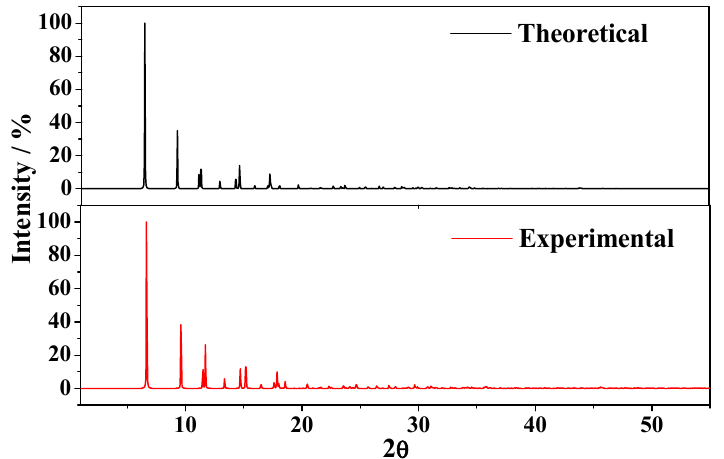
Figure 3. Comparison of the X-ray diffraction patterns of ZIF-75 derived from the experimental [2] and theoretical tetragonal crystal structures.